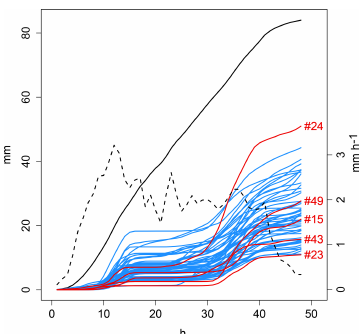
Figure A2. Cumulative totals of hourly precipitation (mm, left y axis) over 48h starting at 21 August 2005 07:00UTC ( x axis), as simulated in 56 members (blue lines) that are downscaled from 20CR. Mean values are given for a control area in northeastern Switzerland. Ensemble members (#23, #43, #15, #49, #24) representing the quartiles of the distribution are highlighted in red. For comparison, cumulative totals in the CombiPrecip dataset are shown (black line), as well as the hourly time series in CombiPrecip (dashed line; mm on the right y